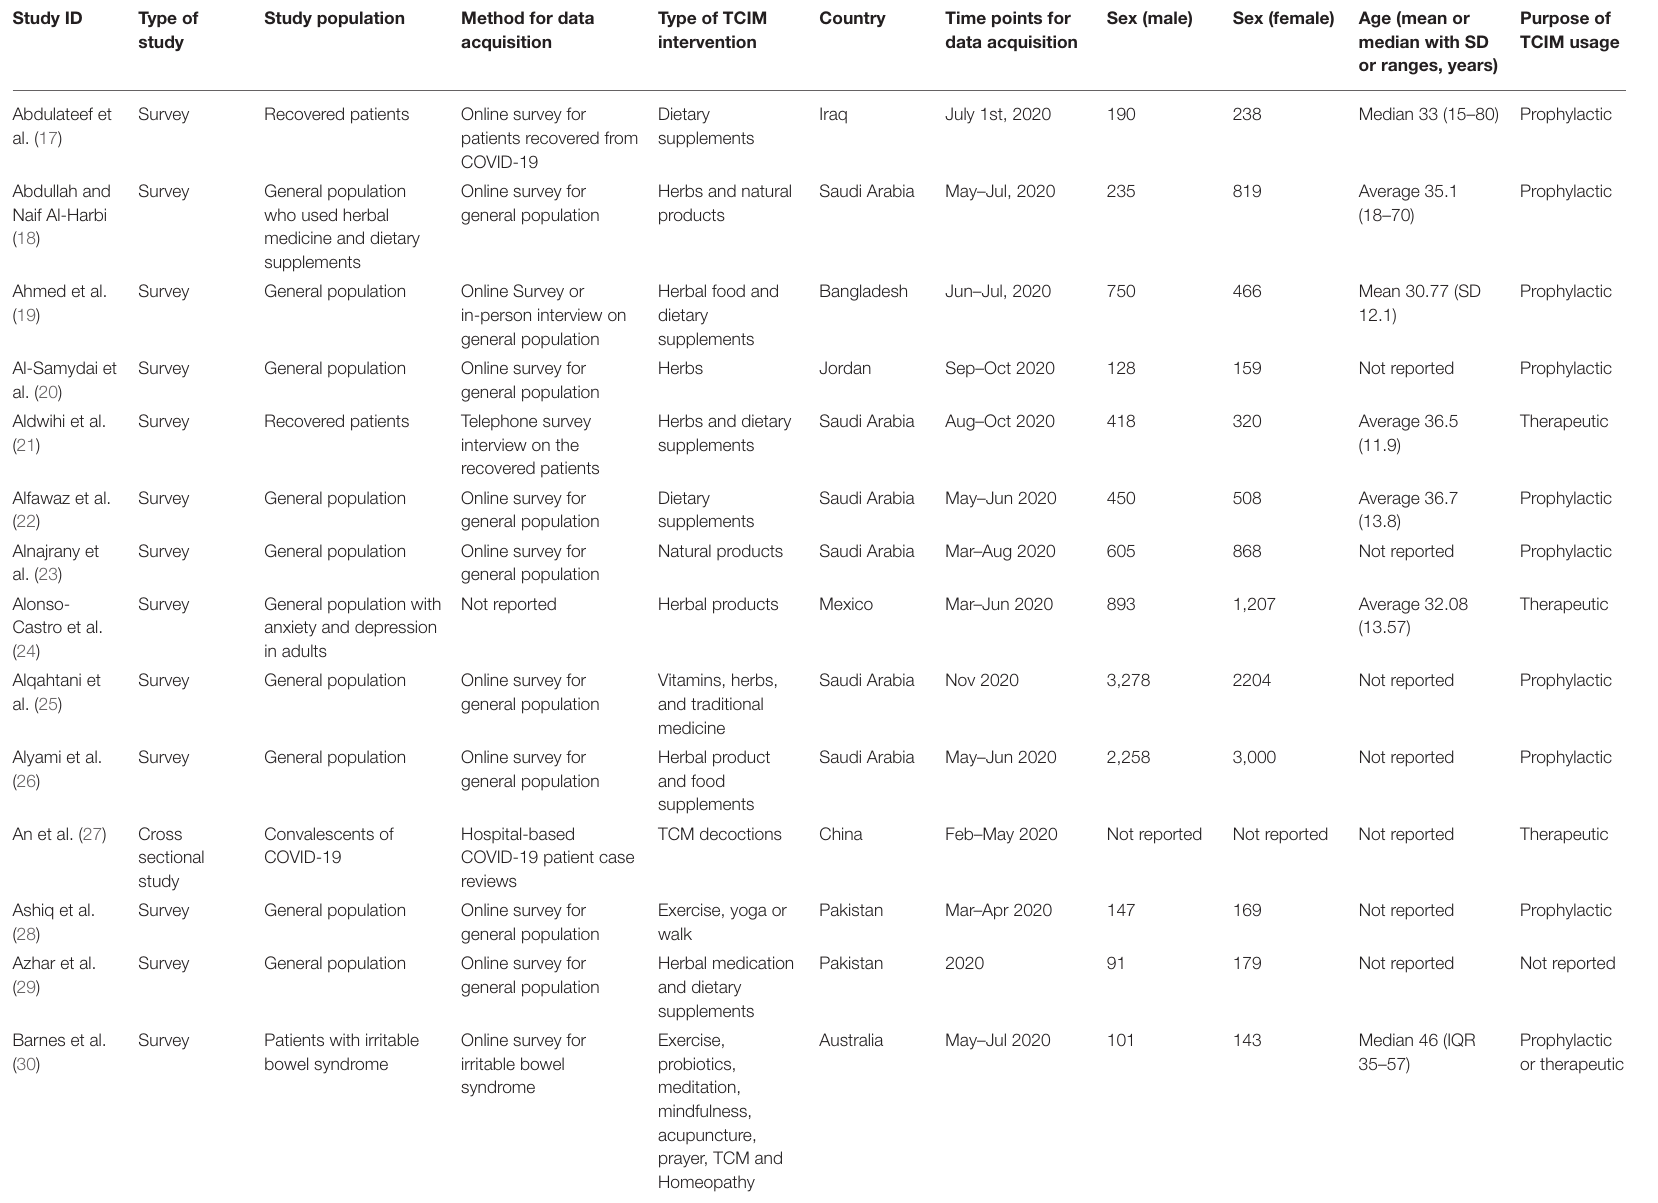
TABLE 1 | Summary of the included